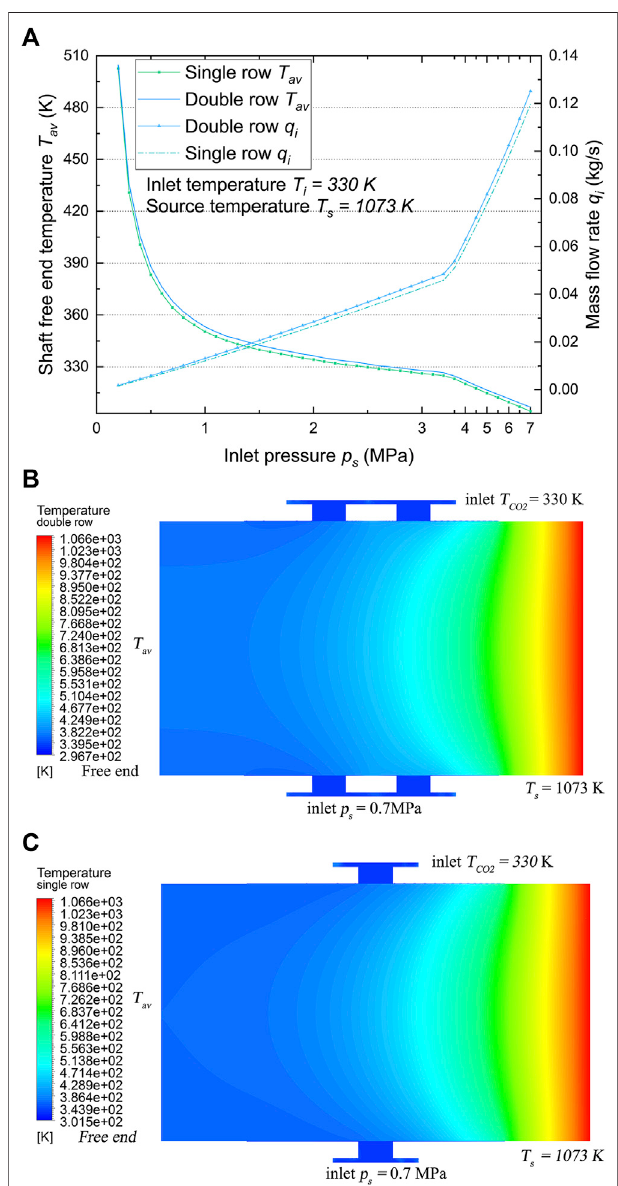
FIGURE 6 | (A) Average temperatures T av at the free end of journal and inlet mass fl ow rate q i versus inlet pressure p s . (B) The temperature fi eld of the journal with a double-row inlet cooler. (C) The temperature fi eld of the journal with a single-row inlet cooler. The cooling stream temperatures, T CO2 = 330 K. The temperature of the heat source, T s = 1073